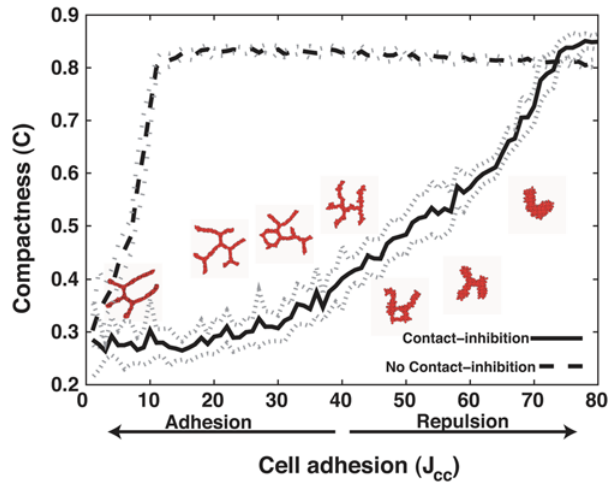
Figure 7. Compactness ( C = A cluster / A hull ) of 128-cell clusters on 200 6 200-pixel lattices ( , 400 m m 6 400 m m) after 5,000 MCS ( , 40 h) for standard chemotaxis, as a function of the adhesion between endothelial cells, J ( c , c ). For J ( c , c ) , 40 (i.e., J ( c , c ) , 2 J ( c , M ) the cells adhere without chemotaxis. Insets: Representative configura- tions after 5000 MCS ( , 40 h).